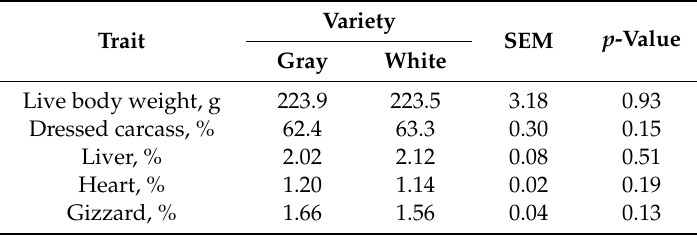
Table 4. Carcass traits of two varieties of Japanese quails.